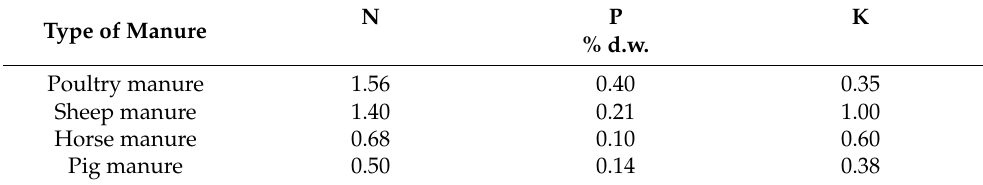
Table 2. Nutrient composition of different manures (from Therios, 1996) [85]. Type of